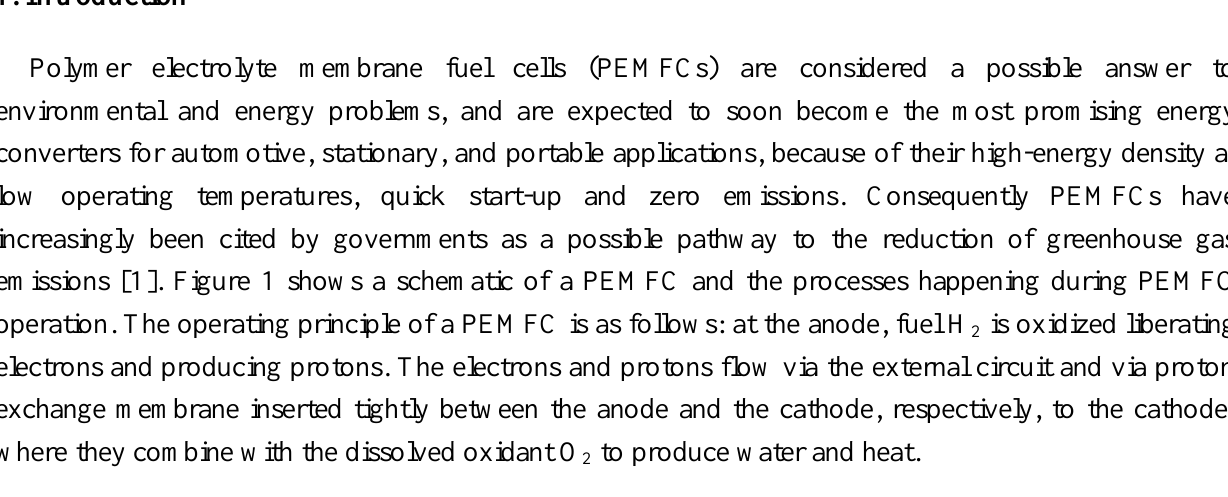
Figure 1. Schematic picture of the operating principle of a typical